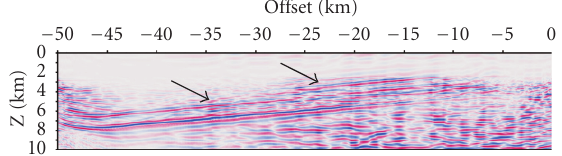
Figure 6: PSDM-imaging result using all crosscorrelation traces. Arrows indicate the artifact events.